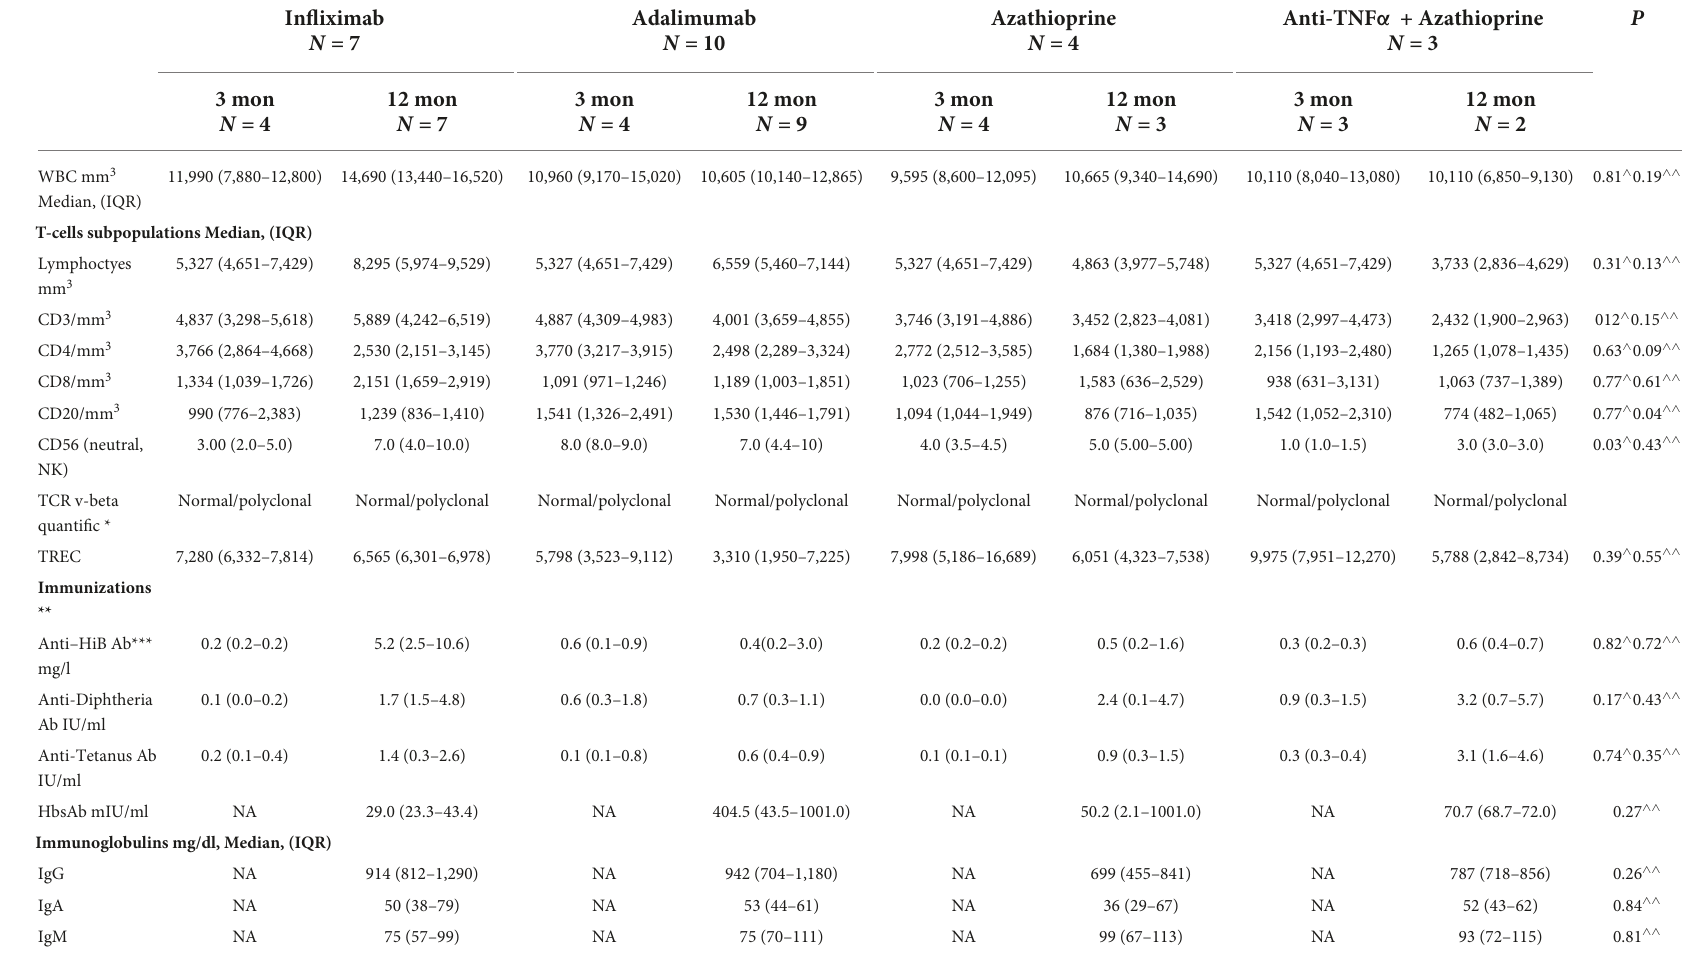
TABLE 6 B-cell and T-cell function of the newborns exposed to Infliximab, Adalimumab, Azathioprine, or combination therapy. Infliximab N =